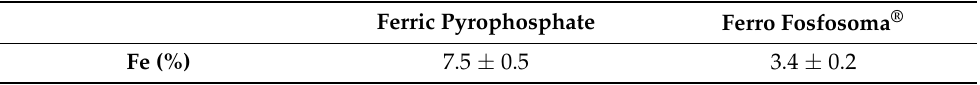
Table 2. Fe percentage after dissolution in HCl 0,1 M of the indicated formulations. Results are expressed as mean ± standard